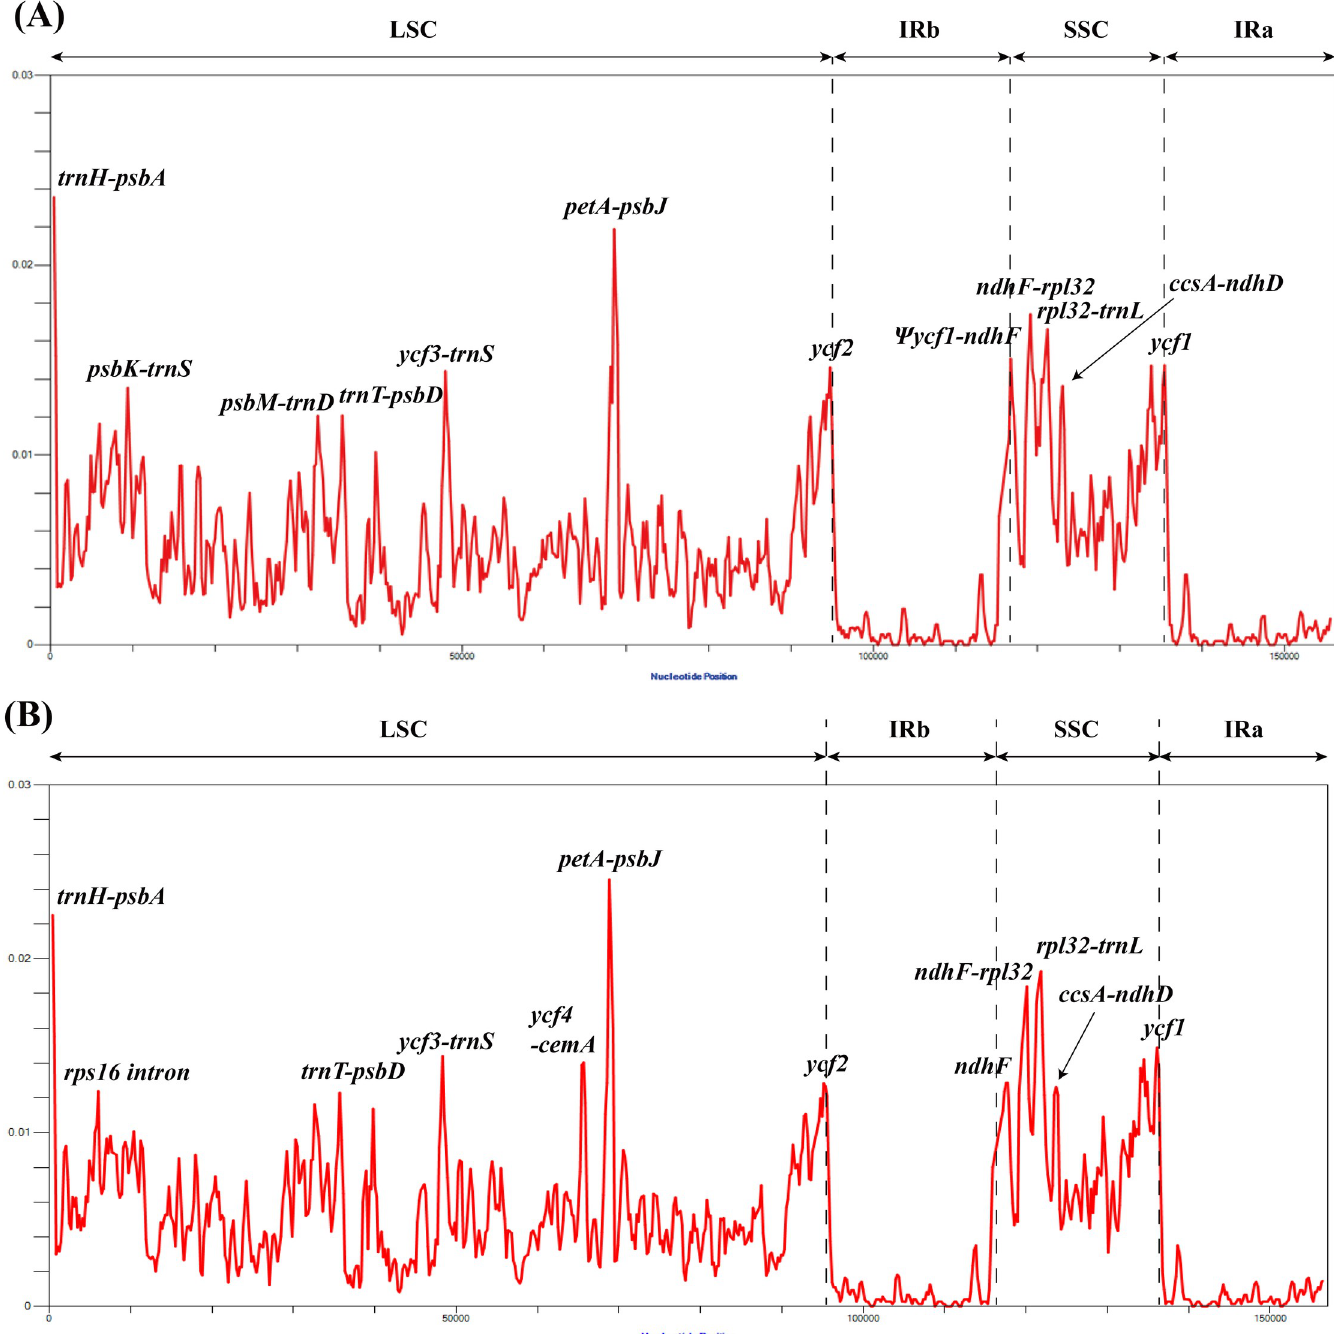
Fig 4. Comparison of high Pi value regions by sliding window analysis. (A) Sliding window analysis showing high Pi value regions among the complete plastomes of 17 Lindera species. (B) Sliding window analysis showing high Pi value regions among the complete plastomes of 24 Laureae species. The window length was 600 bp and the step size was 200 bp in both analyses. The X-axis represents the midpoint position of each window, while the Y-axis represents nucleotide divergence (Pi) values in each